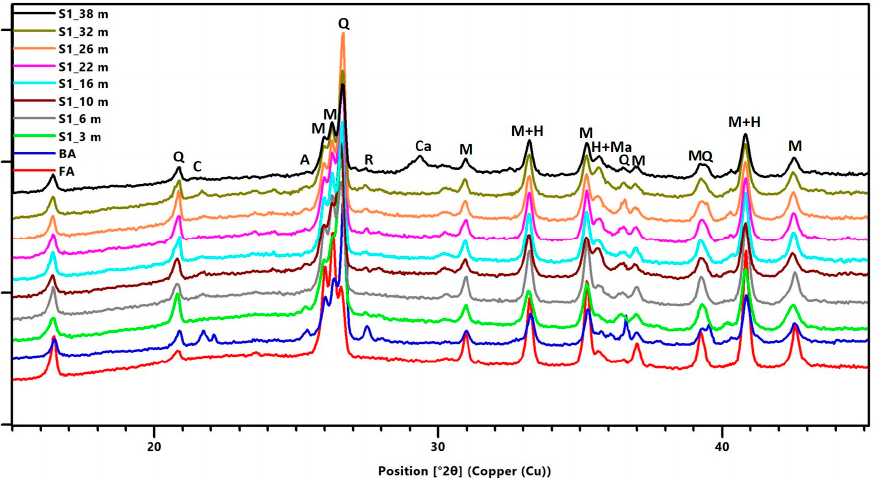
Figure 6. X-ray Diffraction Patterns of Fresh FA, Fresh Bottom Ash BA and Deposited Bottom Ash from Core Borehole S1; M-mullite (01-084-1205), Q-quartz (01-089-8934), Ca-calcite (01-078-4614), H-hematite (01-089-8103), Ma-magnetite (01-084-2782), A-anatase (01-089-4921), R-rutile (04-005-4674), C-cristobalite (04-007-2379).